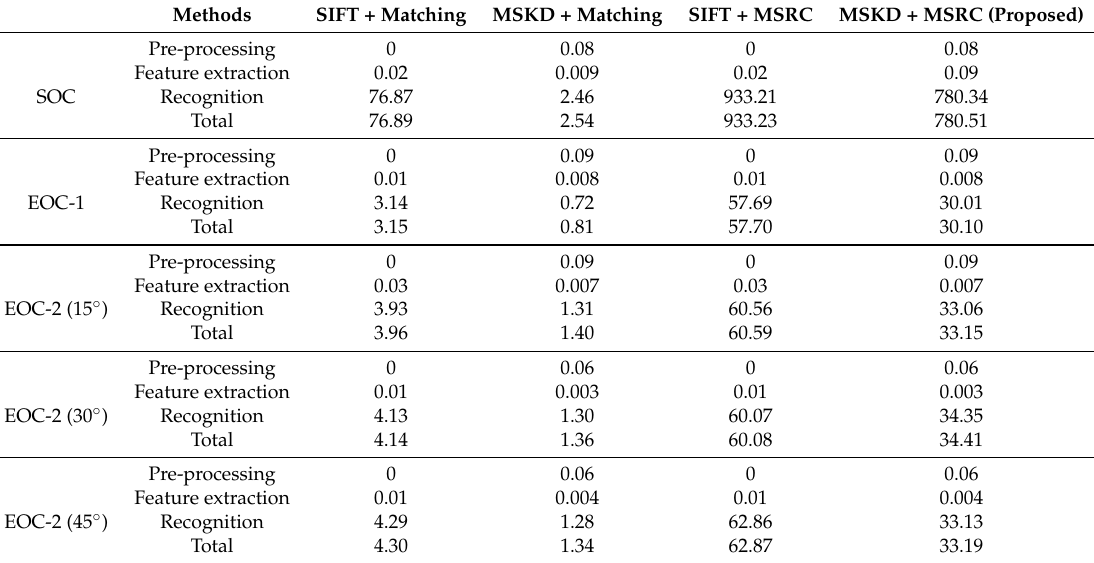
Table 9. Comparison between the execution time (s) of different methods on MSTAR